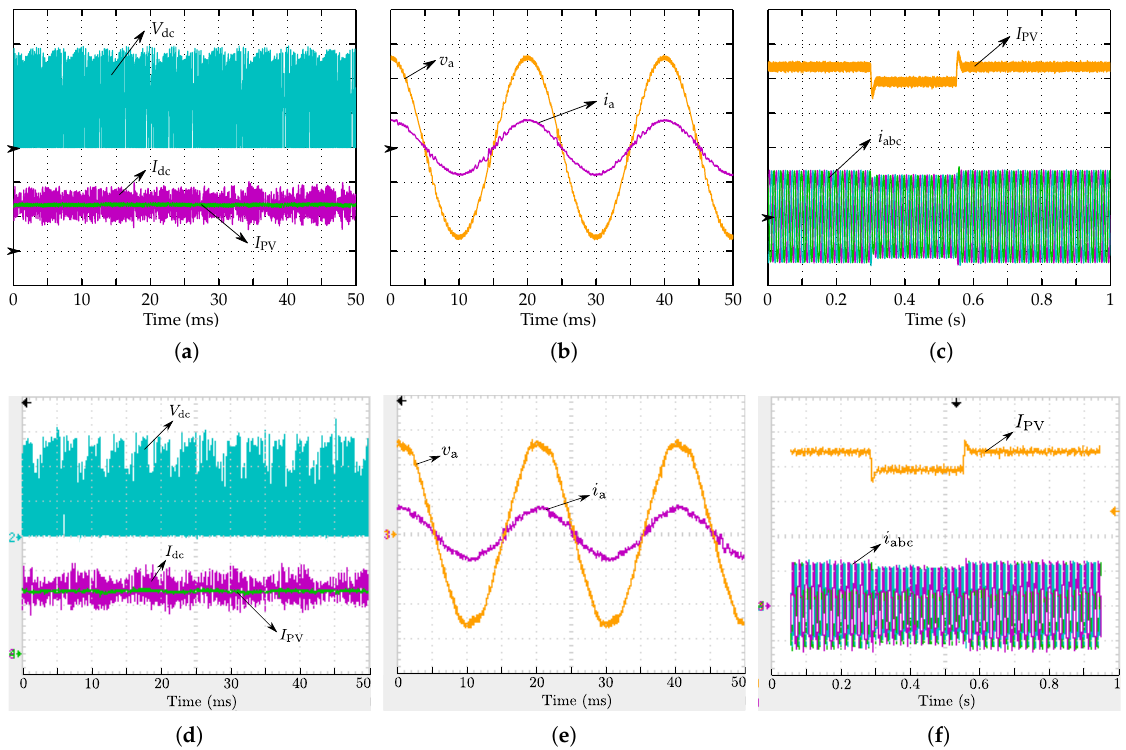
Figure 8. Simulation and experimental results in no-load conditions. ( a , d ) ‘dc link’ voltage V dc [100V/div], PV array current I PV and shunt converter dc current [5A/div]. ( b , e ) Grid line-to-ground voltage v a [60V/div] and current i a [5A/div]. ( c , f ) Irradiance steps up and down between 1kW/m 2 and 0.9kW/m 2 :